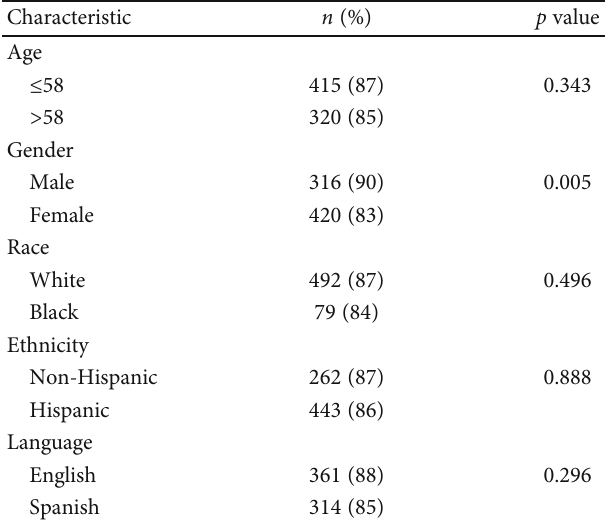
Table 3: Comparison of adequate cecal withdrawal time across patient demographic characteristics ( n = 896 ).